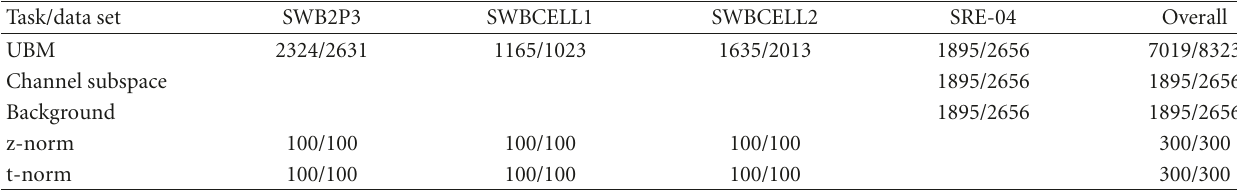
Table 1: Development data sets used in the experiments. The figures in the table correspond to the number of conversation sides from the data sets that were used in di ff erent